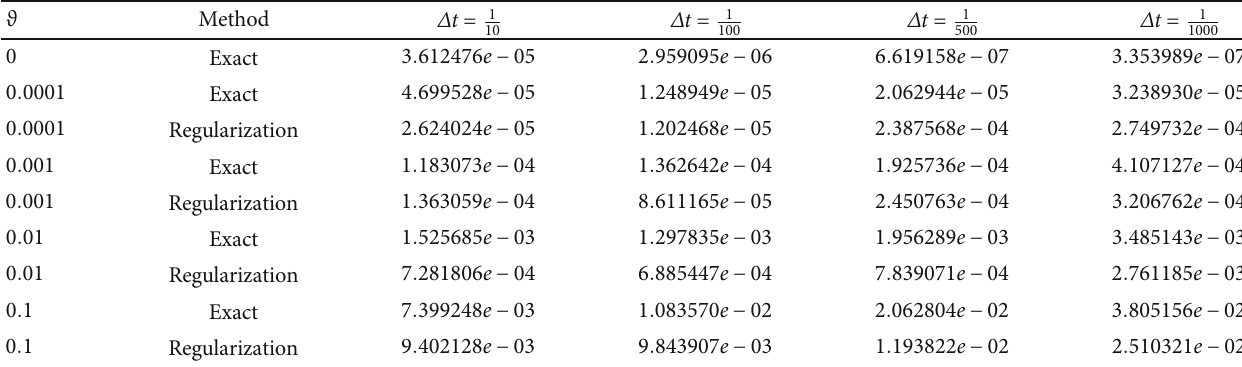
Figure 3: The exact solution (left) and the absolute error (right) of Example 2 with Δ t = 0 : 001 and h = 0 : 01 , without noise. ff erent values of Δ t and ϑ with h = 0 : 05 Table 2: L ∞ errors of Example 2 for di